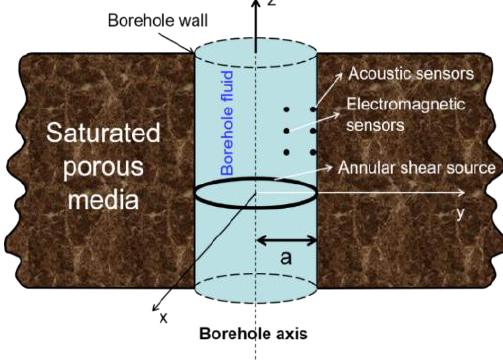
Figure 1. Schematic diagram for SH-TE logging.